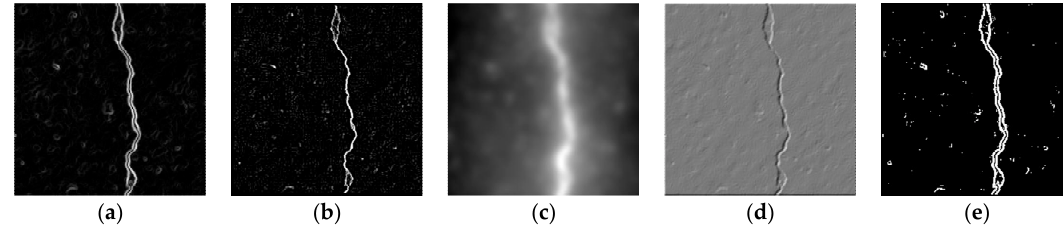
Figure 5. Crack edge detection results of image with transverse crack using different filters: ( a ) Sobel; ( b ) LoG; ( c ) Gabor; ( d ) steerable; ( e ) homogeneity.